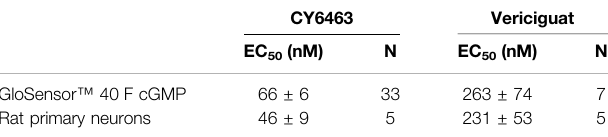
TABLE 1 | EC 50 values for CY6463 and